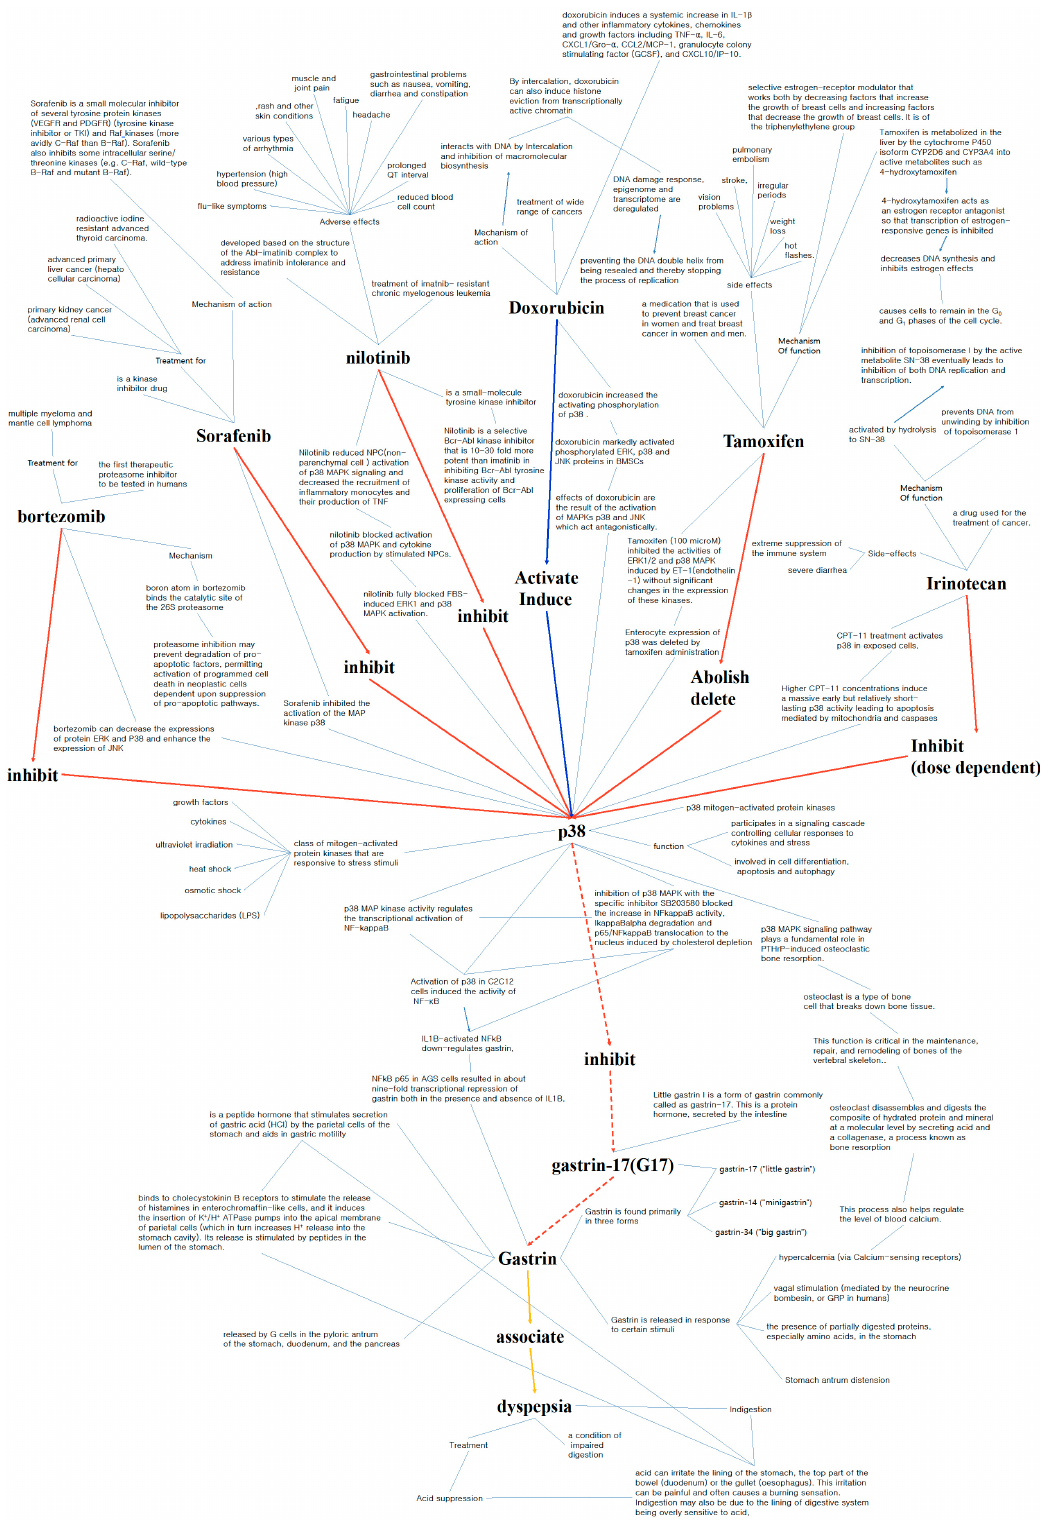
Figure 4. Extracted drug-protein–side effect paths for sorafenib and dyspepsia.